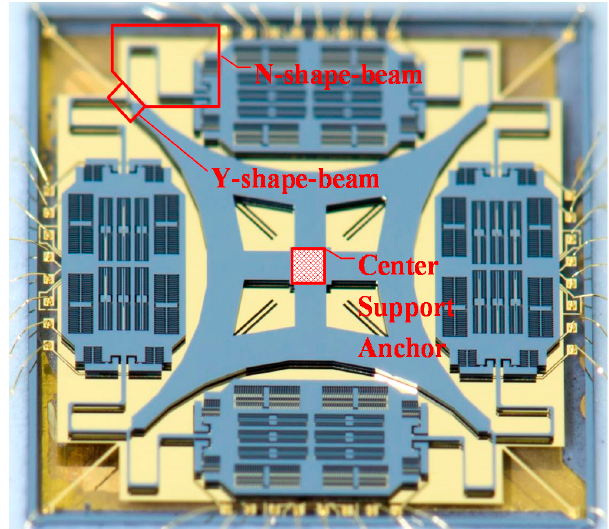
Figure 1. Optical photograph of a Center Support Quadruple Mass Gyroscope, with four lumped masses connected through the N-shape-beams and the Y-shape-beams, supported by a single center support anchor.